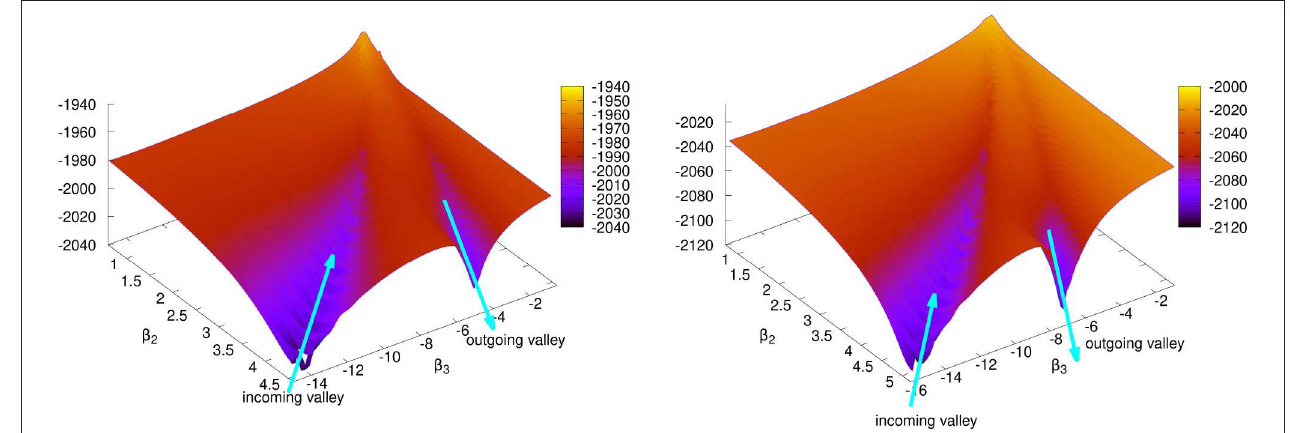
FIGURE 6 | Plotted are the PESs calculated, using the DC-TDHF method, for central collisions of 40,48 Ca+ 238 U, with the equatorial orientation of 238 U. The PES on the left is for the 40 Ca+ 238 U system at E c.m. = 211 MeV, while the PES on the right is for the 48 Ca+ 238 U system at E c.m. = 203